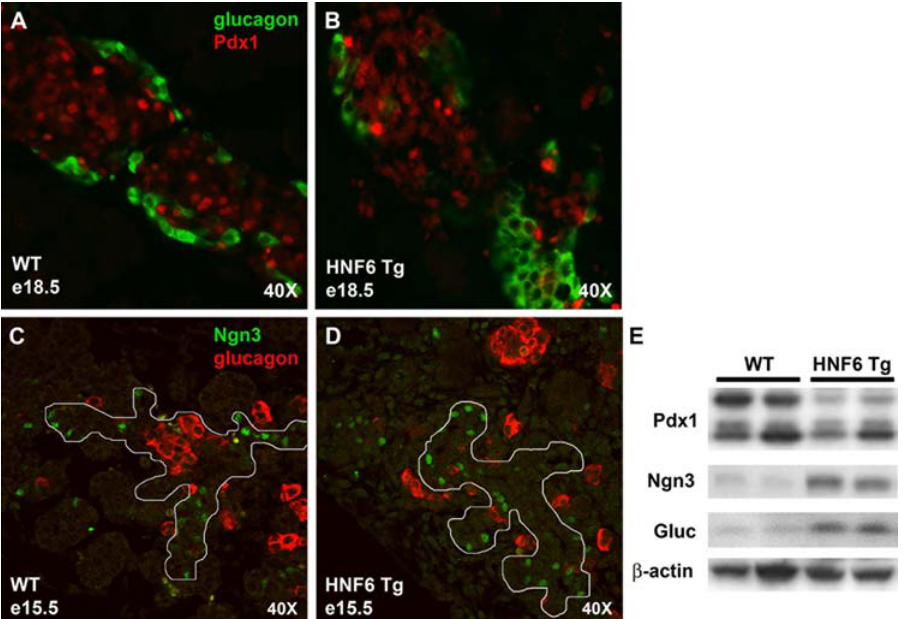
Figure 5. Immunofluorescent and western blot validation of microarray results for Hnf6 transcriptional targets. No changes in Pdx1 expression (red) were observed by co-immunohistochemistry in e18.5 WT ( A ) and Hnf6 Tg ( B ) embryonic pancreata (glucagon shown in green). In contrast, Increased numbers of Ngn3 + cells (green) were observed within the pancreatic epithelium (outlined) at e15.5 (glucagon + cells shown in red) in HNF6 Tg pancreata ( C ) as compared to WT pancreata ( D ). P1 pancreatic extracts ( E ) were probed for the expression of the proteins indicated. Values are expressed as a ratio (WT:Hnf6 Tg). Two representative samples for each genotype are shown.